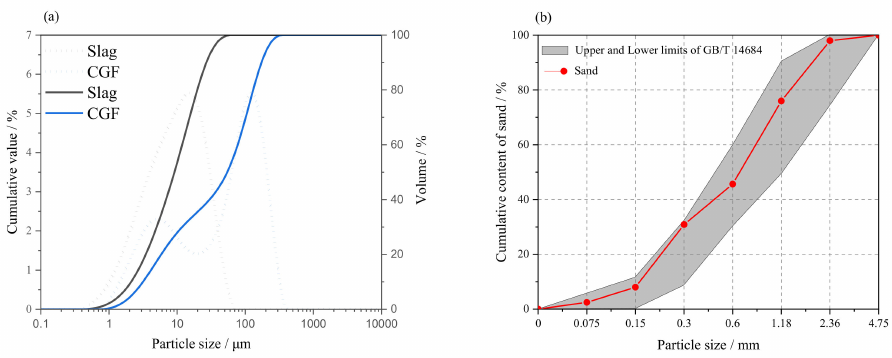
Figure 2. Particle size distribution of raw materials: ( a ) CGF with ground granulated blast furnace slag and ( b ) sand.